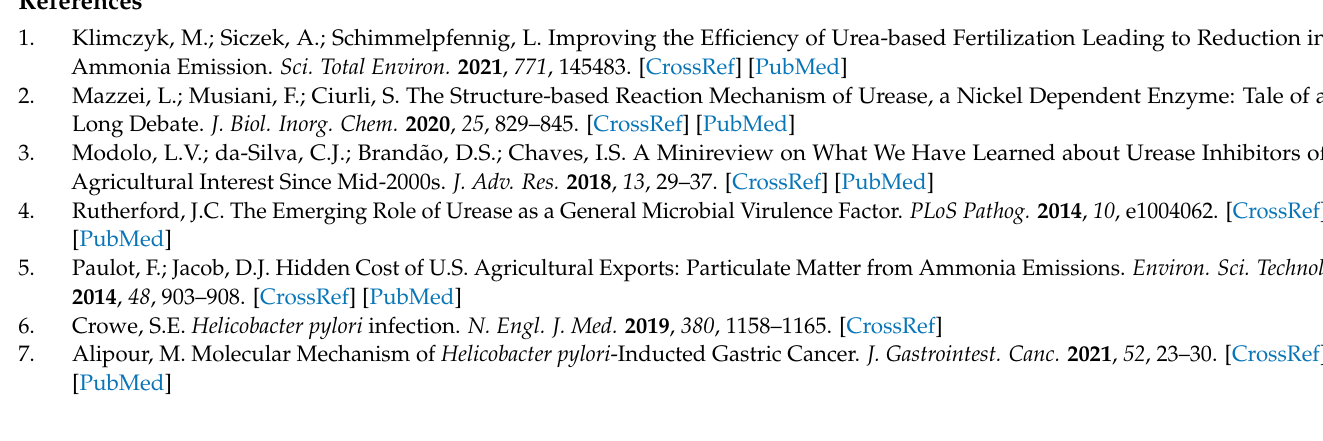
UB3LYP-D3BJ/def2-SVP level of theory, Figure S3. Two different HU-bound complexes ( 2 RS QMa and 2 RS QMb ) optimized at the UB3LYP-D3BJ/def2-SVP level of theory, Figure S4. Potential energy profile (in kcal/mol) and illustrations of the transition state, intermediate and product structures corresponding to the inhibition process of HU obtained at the UB3LYP-D3BJ/def2-SVP level of theory, Figure S5. Selected hydrogen bond distances between N(AHA) and O(Asp363) during a 25 ps QM/MM metadynamics simulation, Figure S6. Selected hydrogen bond distances between N(HU) and O(Asp363) during a 25 ps QM/MM metadynamics simulation, Figure S7. Selected hydrogen bond distances between N(HU) and O(Asp363) during a 15 ps QM/MM metadynamics simulation, Figure S8. Selected hydrogen bond distances between N(DAP) and O(Asp363) during a 50 ps QM/MM metadynamics simulation, Figure S9. HU-bound complexes ( 2 (cid:48) RS QM ) optimized at the (a) UB3LYP-D3BJ/def2-SVP and (b) GFN2-xTB levels of theory. (c) Potential energy profile (in kcal/mol) and illustrations of the transition state, intermediate and product structures corresponding to the hydrolysis process of HU obtained at the UB3LYP-D3BJ/def2-SVP and GFN2-xTB levels of theory, Figure S10. RMSD with respect to the initial conformations during a 10 ns classical MD simu- lation for an AHA-bound complex (1), Figure S11. RMSD with respect to the initial conformations during a 10 ns classical MD simulation for an HU-bound complex (2), Figure S12. RMSD with respect to the initial conformations during a 10 ns classical MD simulation for an HU-bound complex (2 (cid:48) ), Figure S13. RMSD with respect to the initial conformations during a 10 ns classical MD simulation for an NBPTO-bound complex (3), and Cartesian coordinates for QM/MM MD equilibrated and QM-only optimized